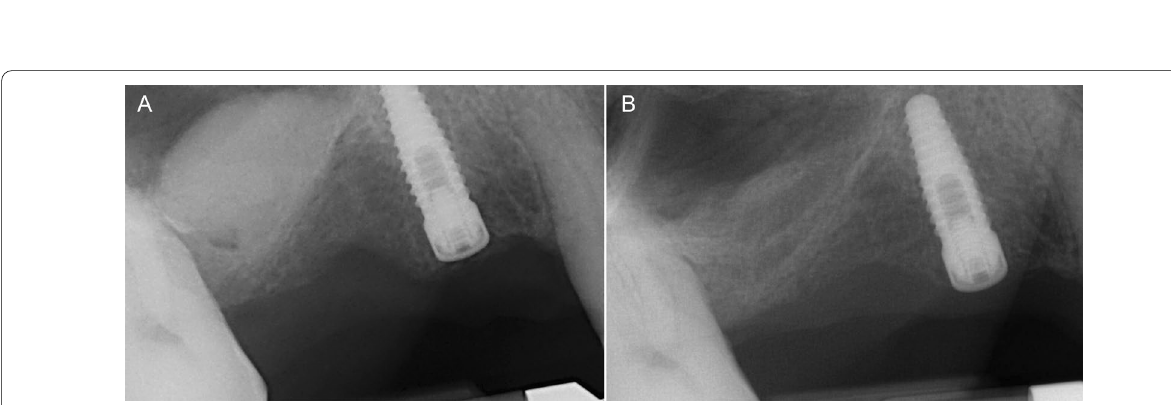
Fig. 6 Periapical radiographs taken immediately after transcrestal sinus floor elevation without simultaneous implant insertion ( A ) and after 6 months of healing ( B ): an evident shrinkage of the regenerated volume is